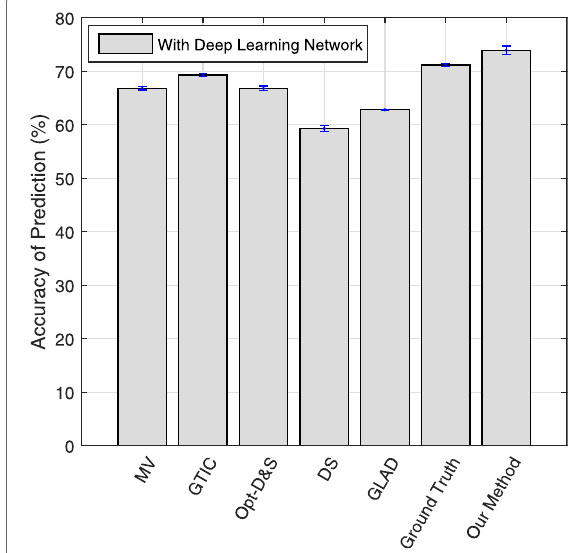
Fig. 8 Prediction comparison. Comparison results of prediction models trained by six